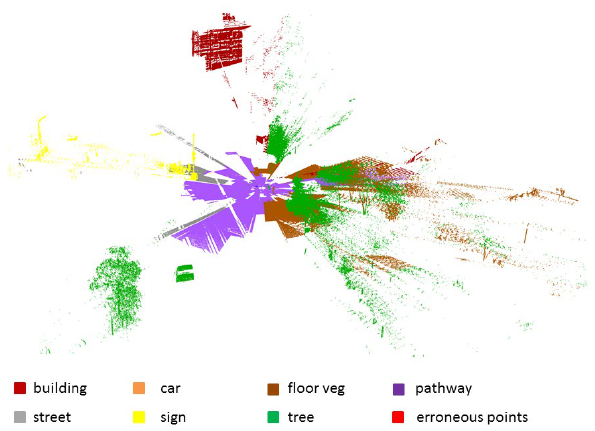
Figure 4. Classified point cloud by the